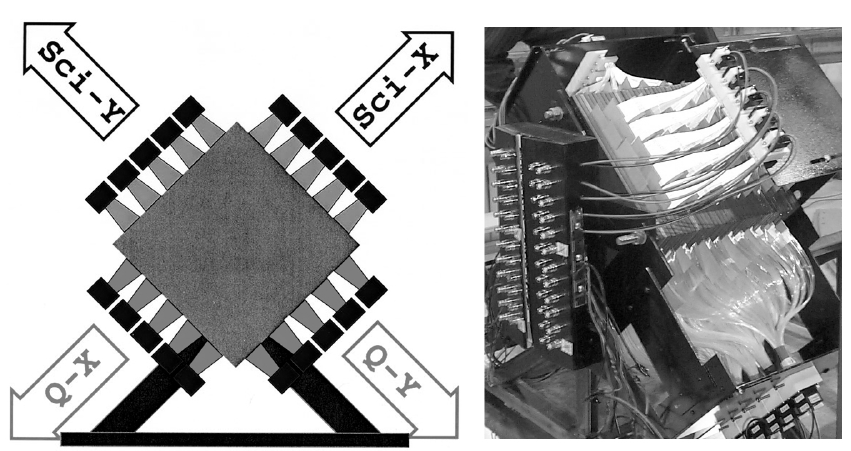
Figure 3. The first dual-readout calorimeter, a prototype for the ACCESS experiment at the Interna- tional Space Station.